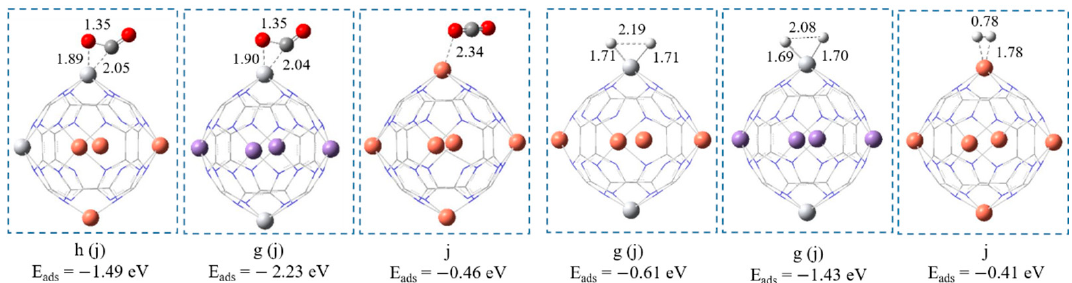
Figure 7. The optimized configurations of CO 2 and H 2 on bi-metal complexes. All bond distances are in Å. Color code: white, Ti; orange, Cu; purple, Mn; red, O; grey, C; blue, N.